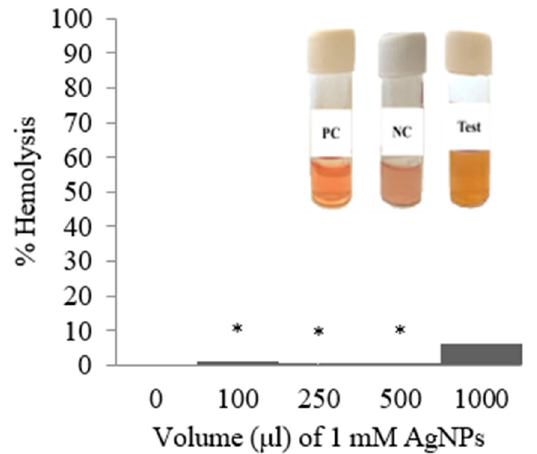
Figure 7. Hemolysis of human erythrocyte at the different volumes of 1 mM AgNPs. A satellite image shows reaction tubes after 3 h incubation at 37 ° C temperature. (PC, positive control; NC, negative control; Test, 1000 µ L of 1 mM AgNPs, and * p < 0.05).